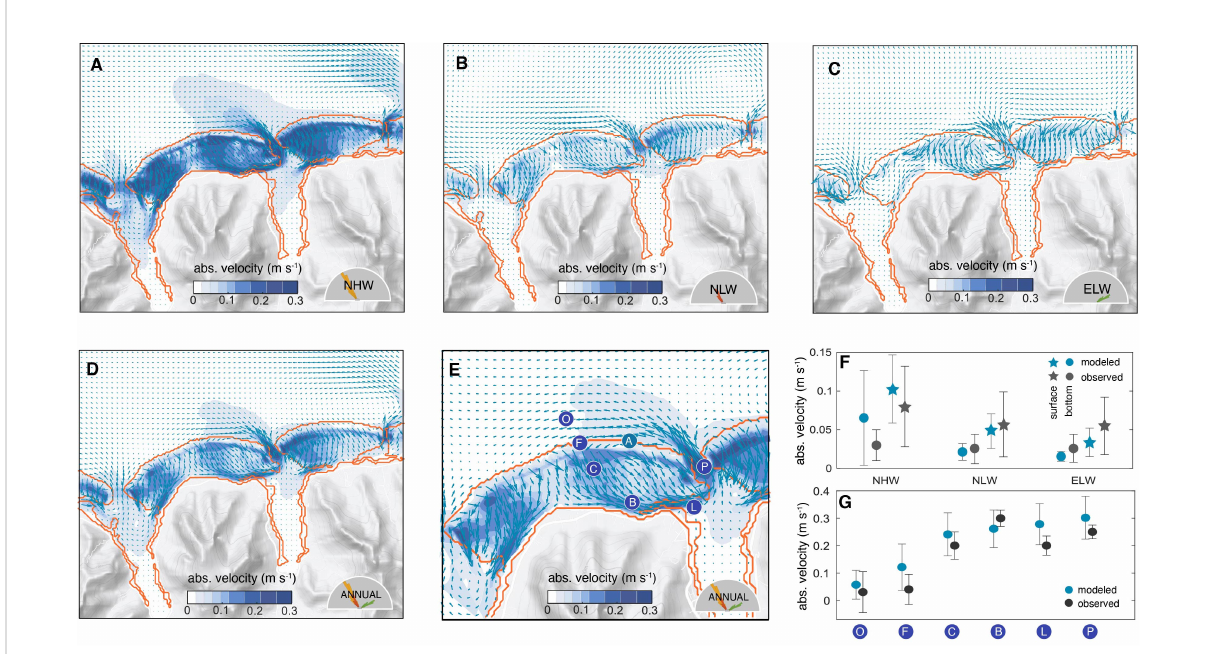
FIGURE 4 Model simulated circulation over the north-shore reefs of Moorea and evaluation with observations: Mean absolute velocity (shading) and direction (arrows) of the surface fl ows for the 14 days associated with the northerly high wave (NHW) regime (A) , the northerly low wave regime (NLW) (B) , and the northeasterly low wave regime (ELW) (C) . Annual mean circulation constructed by combining the three wave regimes according to their relative frequency of occurrence (D) (see text for details), with a zoom and with the locations of the survey measurements of Hench et al. (2008) (blue circles) along a reef transect following the fl ow from the open ocean (O) to the lagoon (L) and to the pass (P) (E) . Also shown as a circle (A) is the location of the long-term ADCP measurements at the LTER 1 site (Washburn, 2019) on the fore reef. (F) Comparison of the model simulated velocities with the long-term ADCP measurements at the LTER 1 site. The observation were strati fi ed according to the wave regime and compared to the corresponding time-slice simulation. Shown are the mean results for the surface fl ows (triangles) and those at depth (circles), with the bars indicating the variability (one standard deviation). (G) Comparison of the model Hench et al. (2008) along the reef transect shown in (E) . The circles indicate the mean over simulation period and the bars indicate the variability (one standard deviation). Since these measurements were taken during a NHW regime, we use the simulation results from this regime only for the